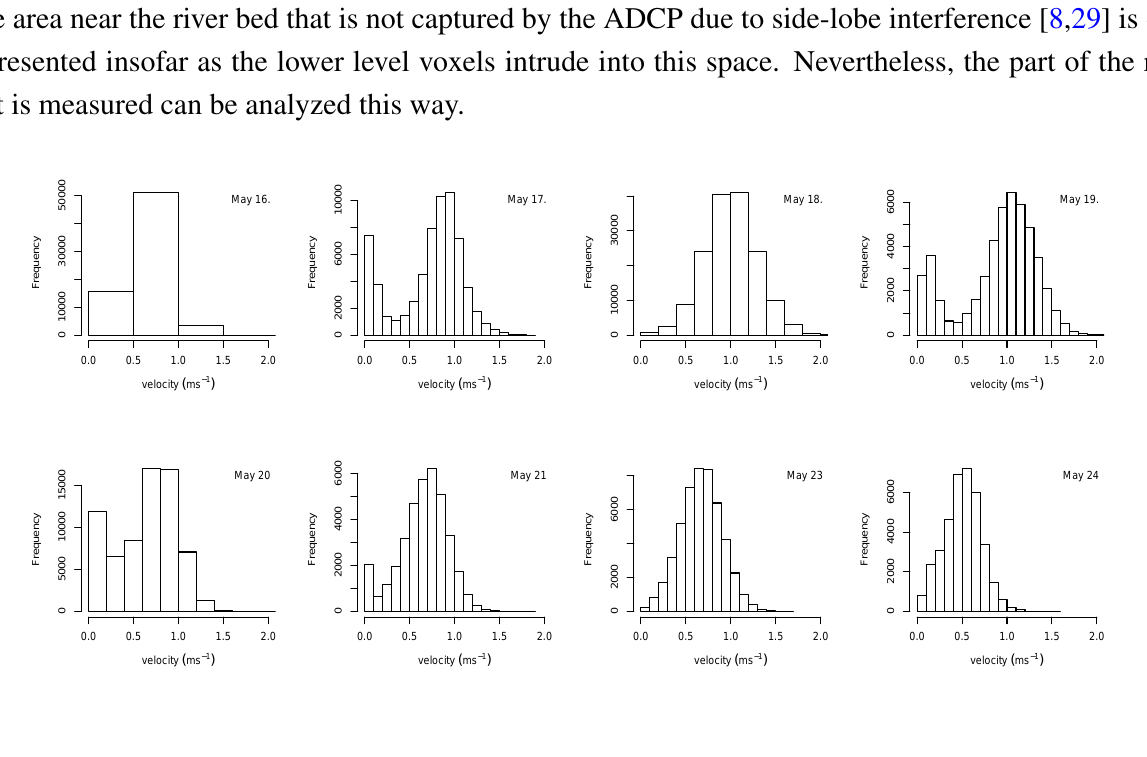
Figure 14. Histogram plots of raw ADCP-measured flow velocities illustrating the changes in magnitude and flow speed distribution during the measurement period. Because of the differing number of points measured each day, the histograms have individual